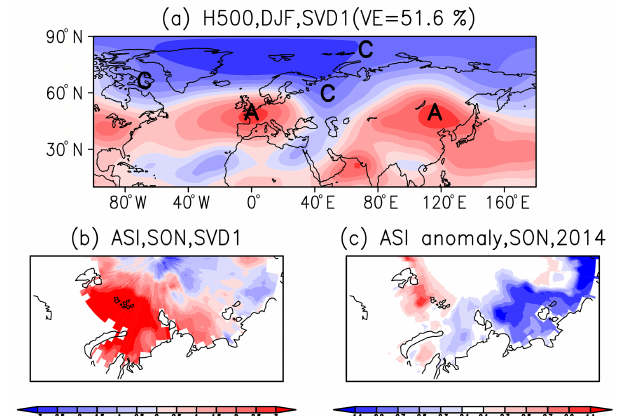
Figure 7. Heterogeneous correlation map of the first SVD mode for detrended and normalized (a) H 500 during DJF and (b) ASI during SON 1979–2014, as well as (c) the ASI anomalies during SON 2014. Letters A and C in panel (a) represent anticyclone and cyclone, respectively.